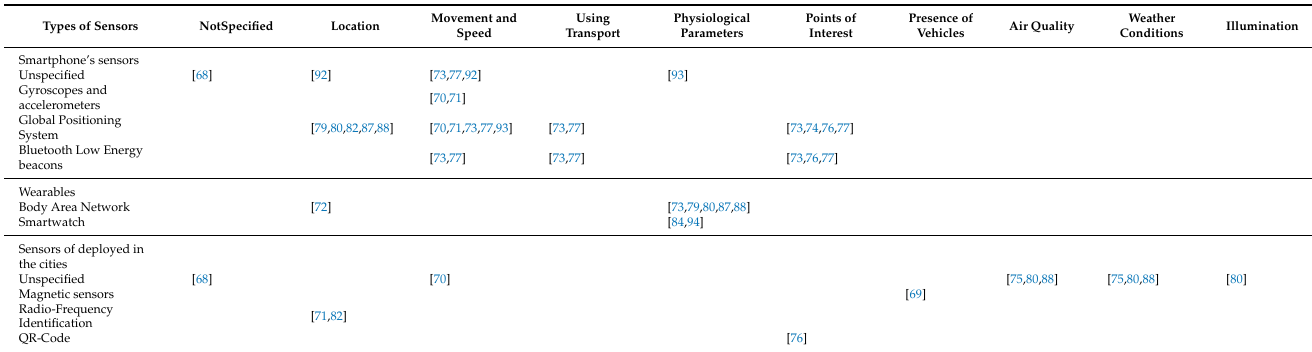
Table 4. Types of data being used by the proposed